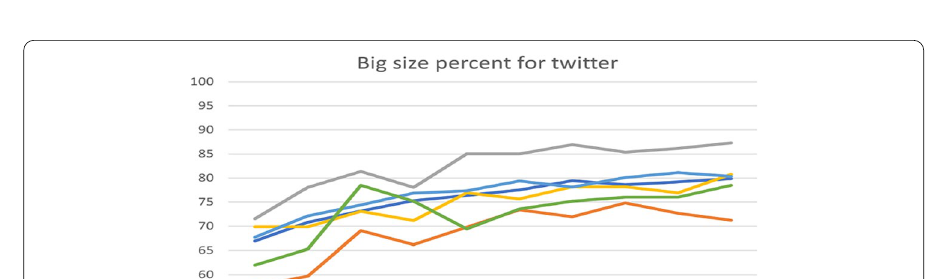
Table 7 Optimal parameter for BigSizePercent Parameter BigSizePercent Platform Instagram Snapchat Twitter Under-sampling